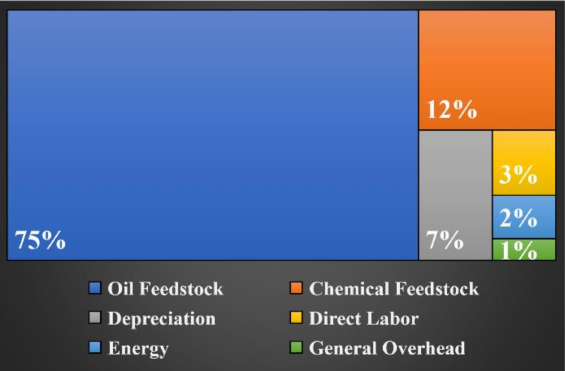
Figure 3. Percentual of the main contributions to biodiesel production cost (adapted from [13]).